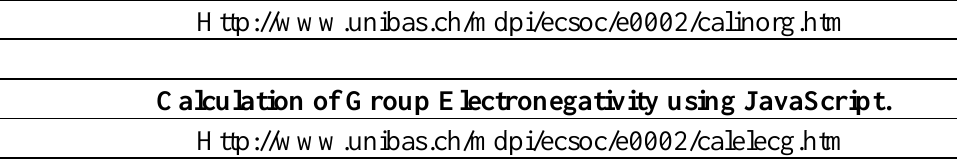
Figure 1. It is clear that two sets of molecule groups can be divided: one set is the hydrophobic molecule groups with pp